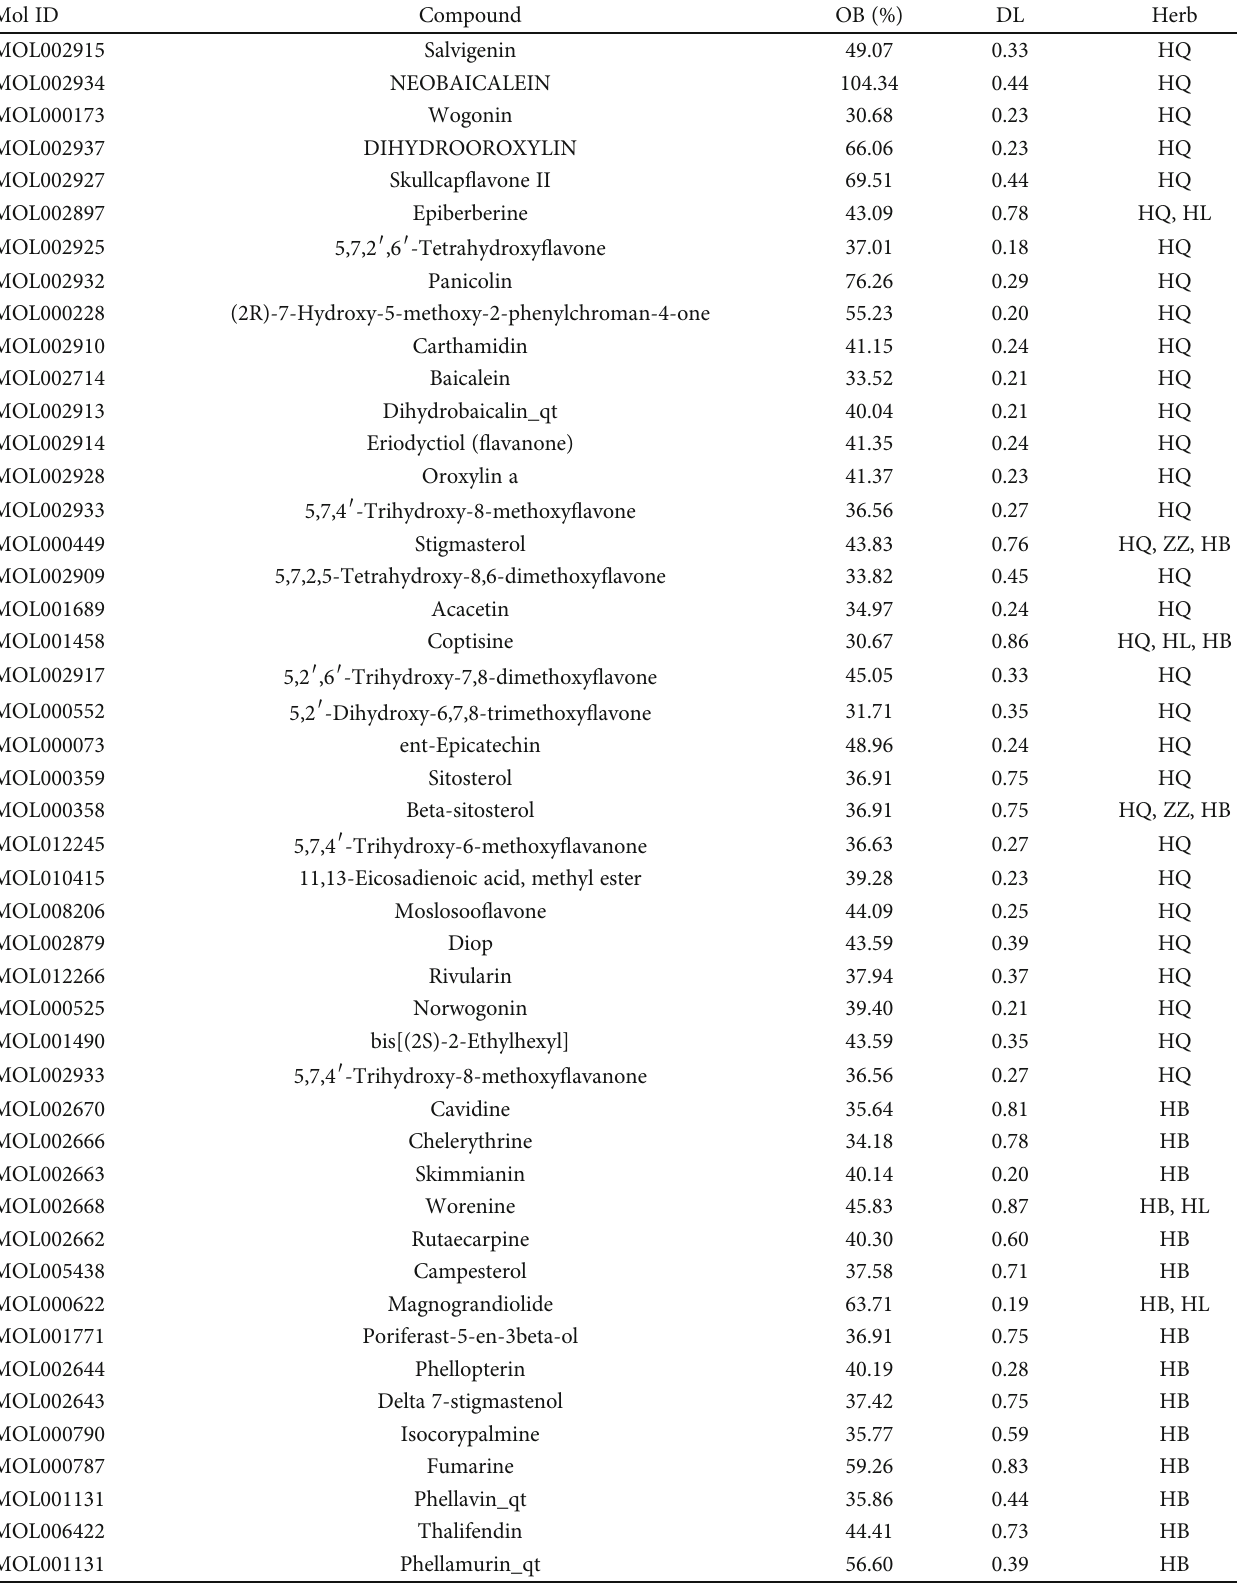
Table 2: Active components network